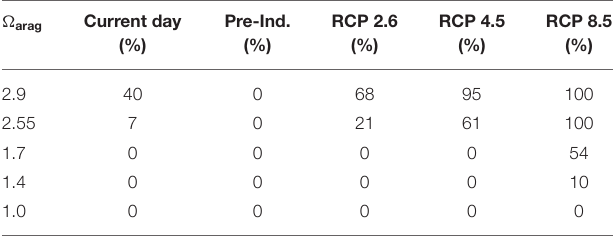
TABLE 1 | Temporal extent (%) of (cid:127) arag below a range of geochemical and physiological thresholds. (cid:127)